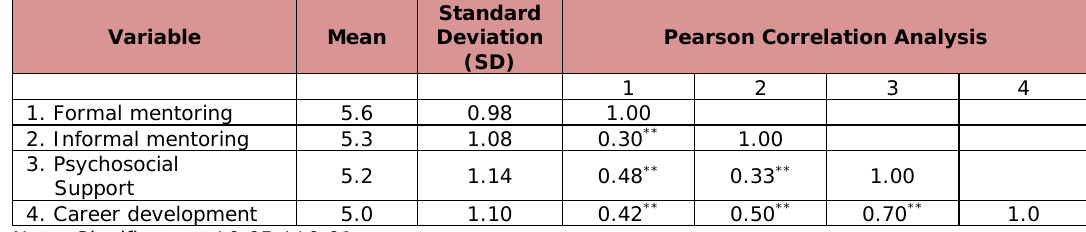
Table 4. “Pearson correlation analysis and descriptive statistics”. Source: